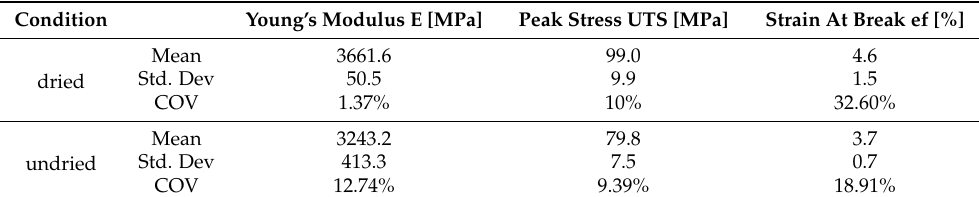
Table 8. Mechanical tensile properties of dried and undried samples.